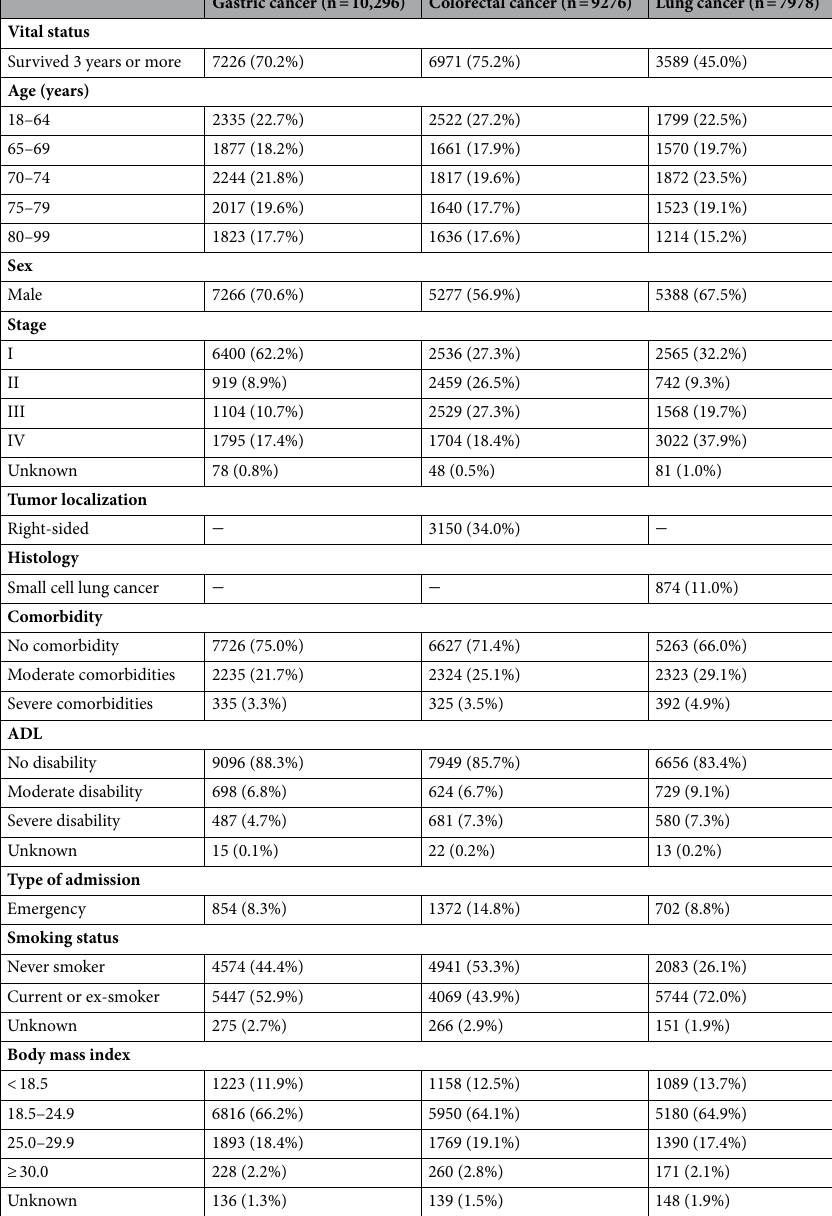
Table 1. Pretreatment demographic and tumor characteristics of patients with gastric, colorectal, and lung cancer. ADL activities of daily